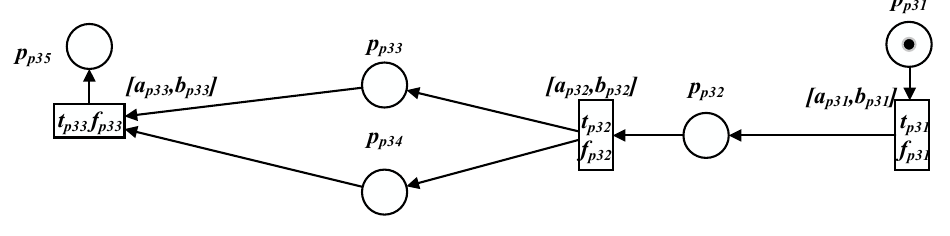
Figure 6. The subnet model N 3